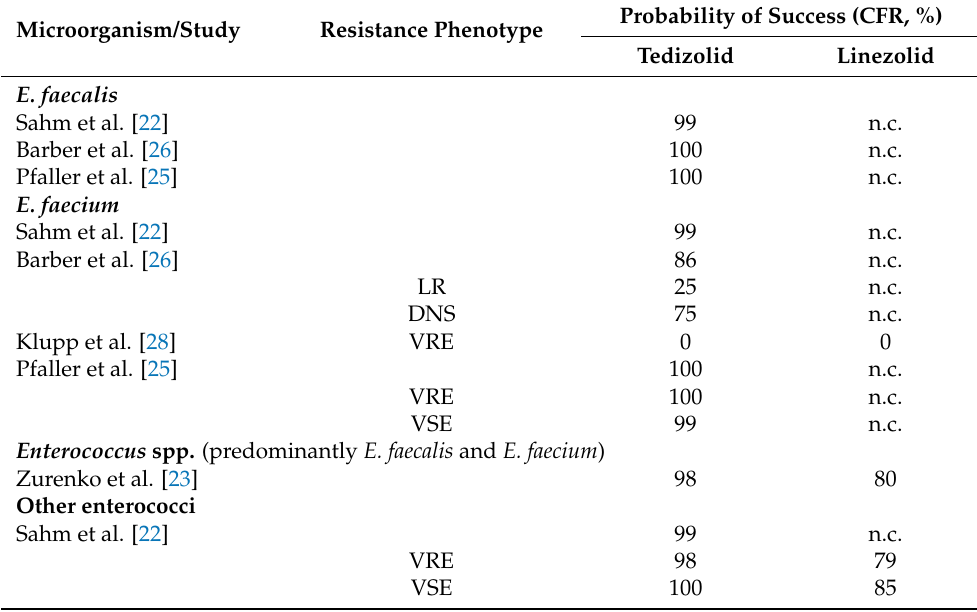
Table 6. Probability of success (expressed as CFR) of tedizolid and linezolid for enterococci.